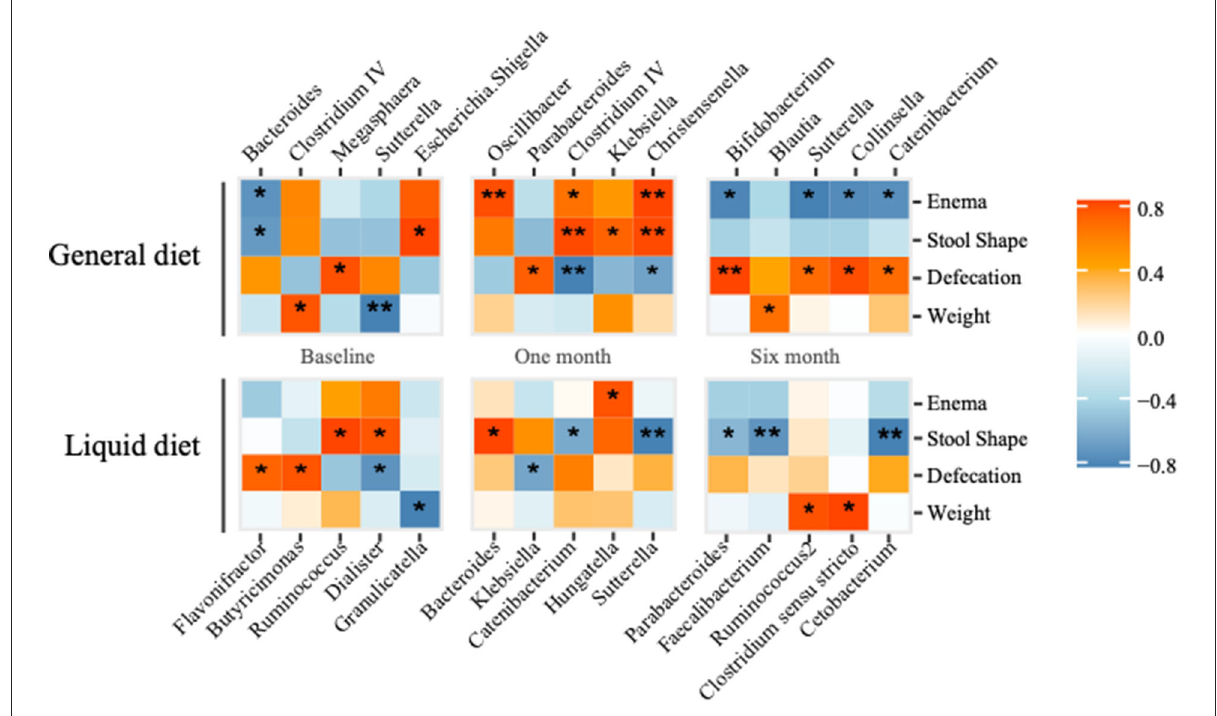
FIGURE6 Correlation analysis between gut microbiota (top five abundant genera) and clinical phonotypes in general diet and liquid diet groups are calculated. * P -value < 0.05, ** P -value <